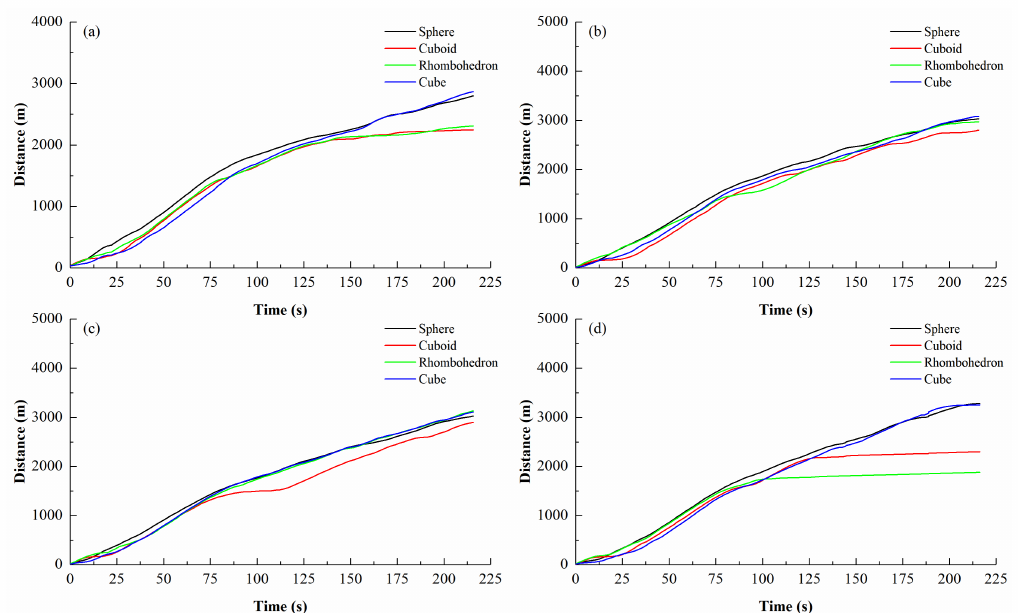
Figure 15. Influence of boulder shape on movement distance under different density conditions, ( a ) ρ = 1200 kg/m 3 , ( b ) ρ = 1500 kg/m 3 , ( c ) ρ = 1800 kg/m 3 , and ( d ) ρ = 2100 kg/m 3